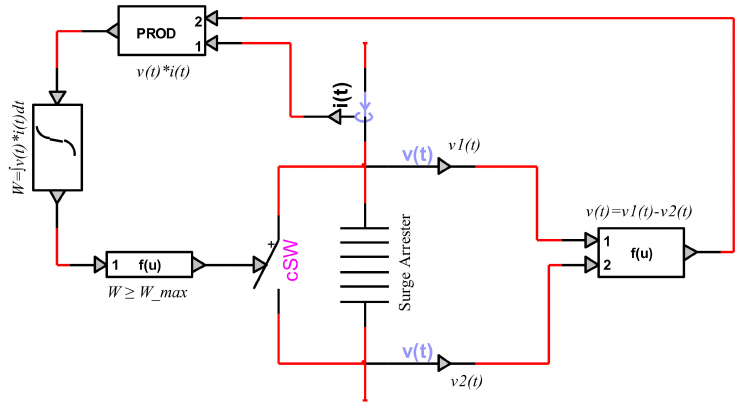
Figure 5. Modeling surge arrester fault via an energy-controlled switch.